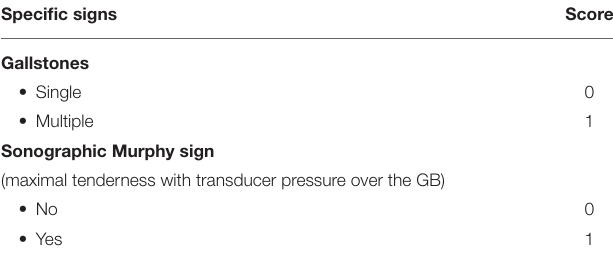
TABLE 3 | Histological parameters (with severity grading) used to define chronic cholecystitis and